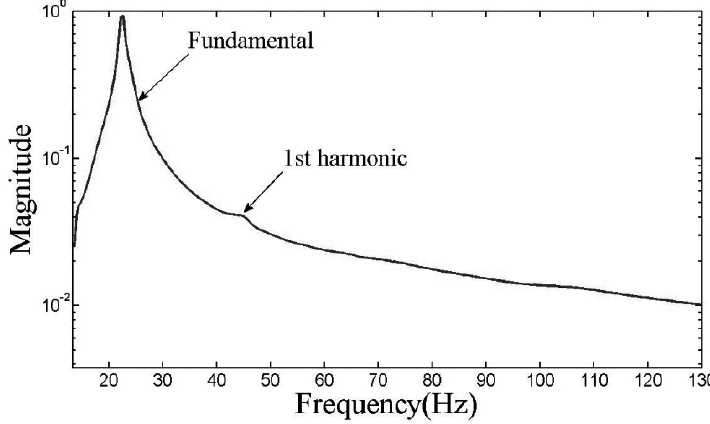
Fig. 11. Spectrum of the measured response of the cracked cantilever beam with α = 0.38 and β = 0.8.